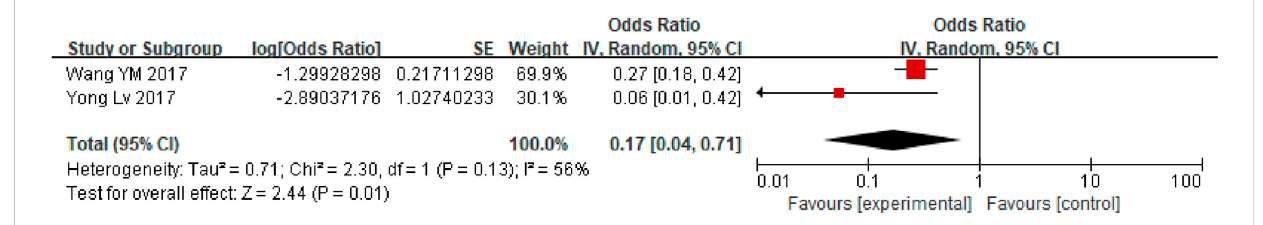
FIGURE 4 The new occurrence of portal vein thrombosis.